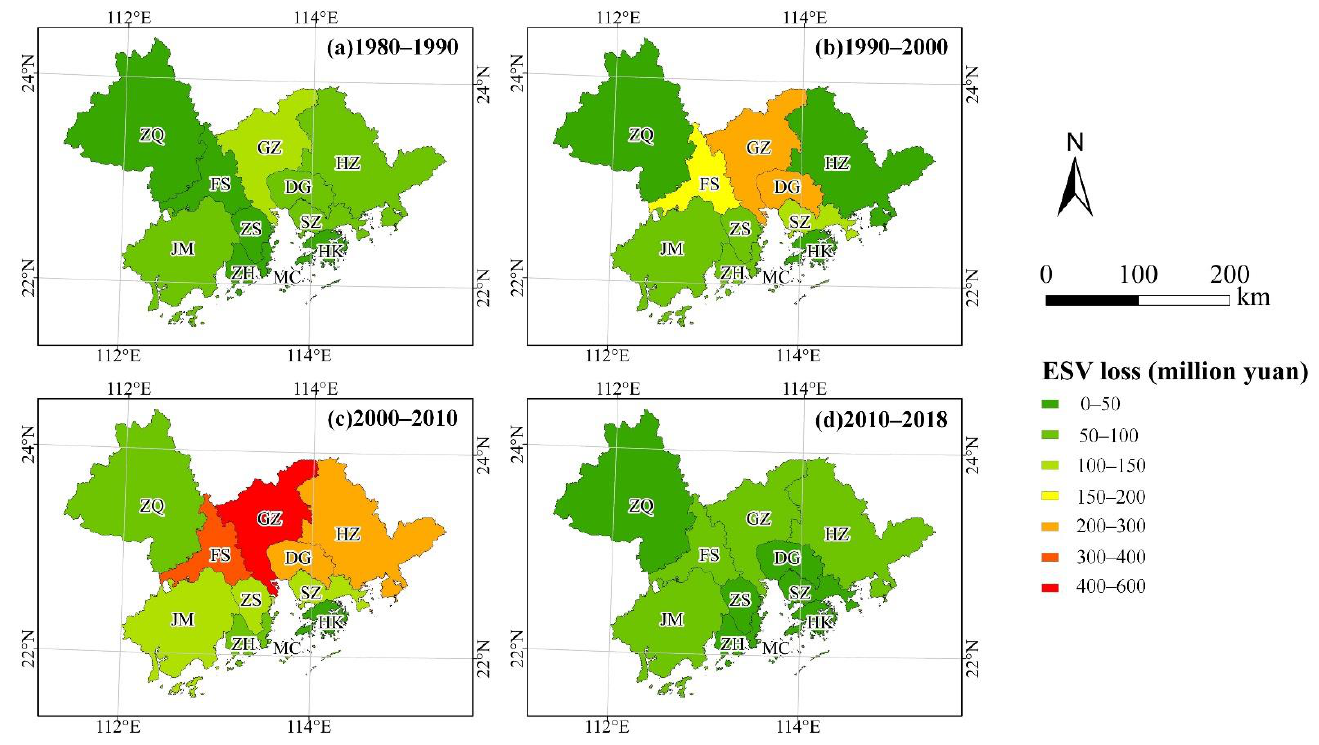
Figure 7. Spatial and temporal distribution of ESV loss of farmland because of urbanization in 11 cities in the four study periods.